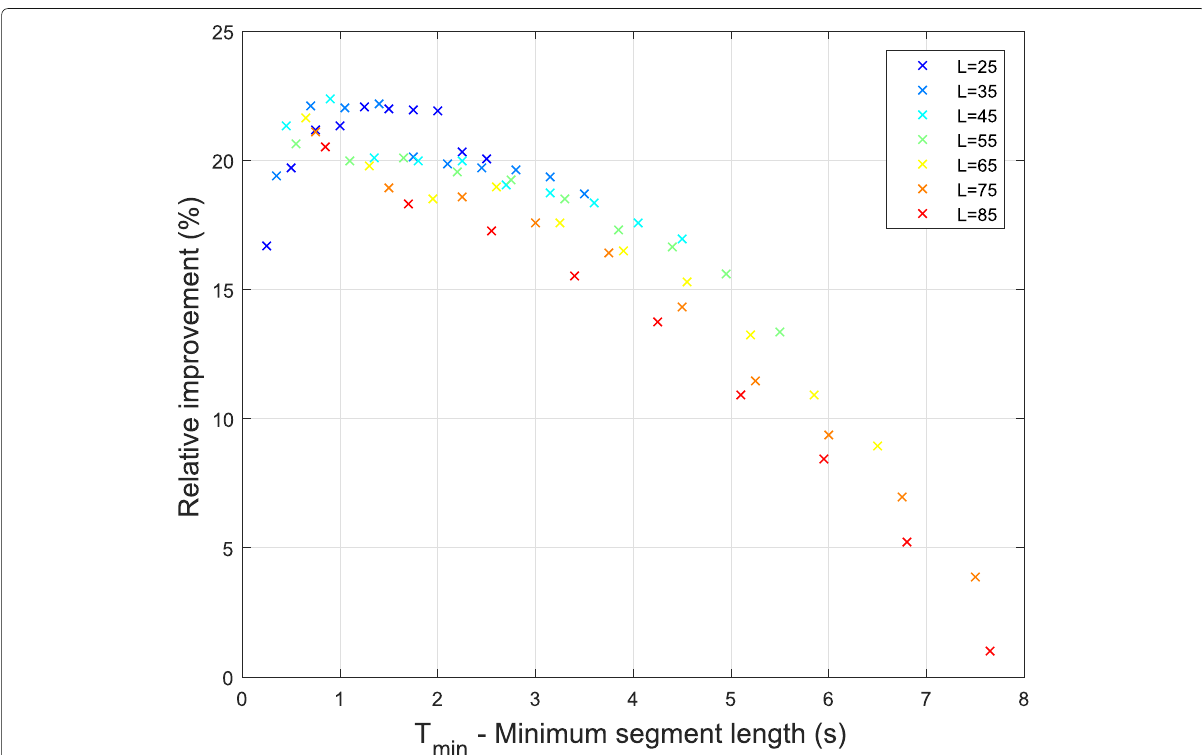
Fig. 4 Relative improvement over the RNN classifier using the HMM resegmentation module for the best feature configuration versus minimum segment length forced by the system